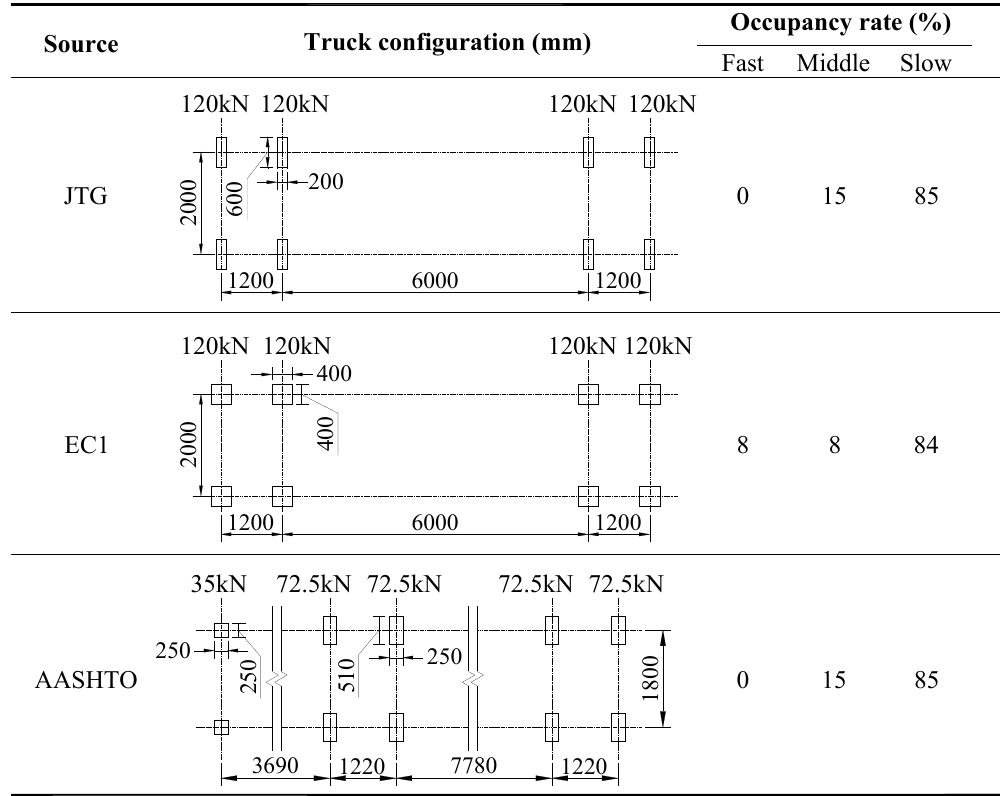
Figure 5. Fatigue truck models in the codes.